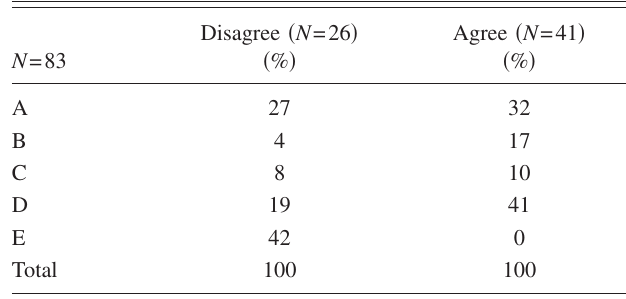
TABLE III. Distribution of reasons invoked by students in re- sponse to CLASS No. 41 after instruction in modern